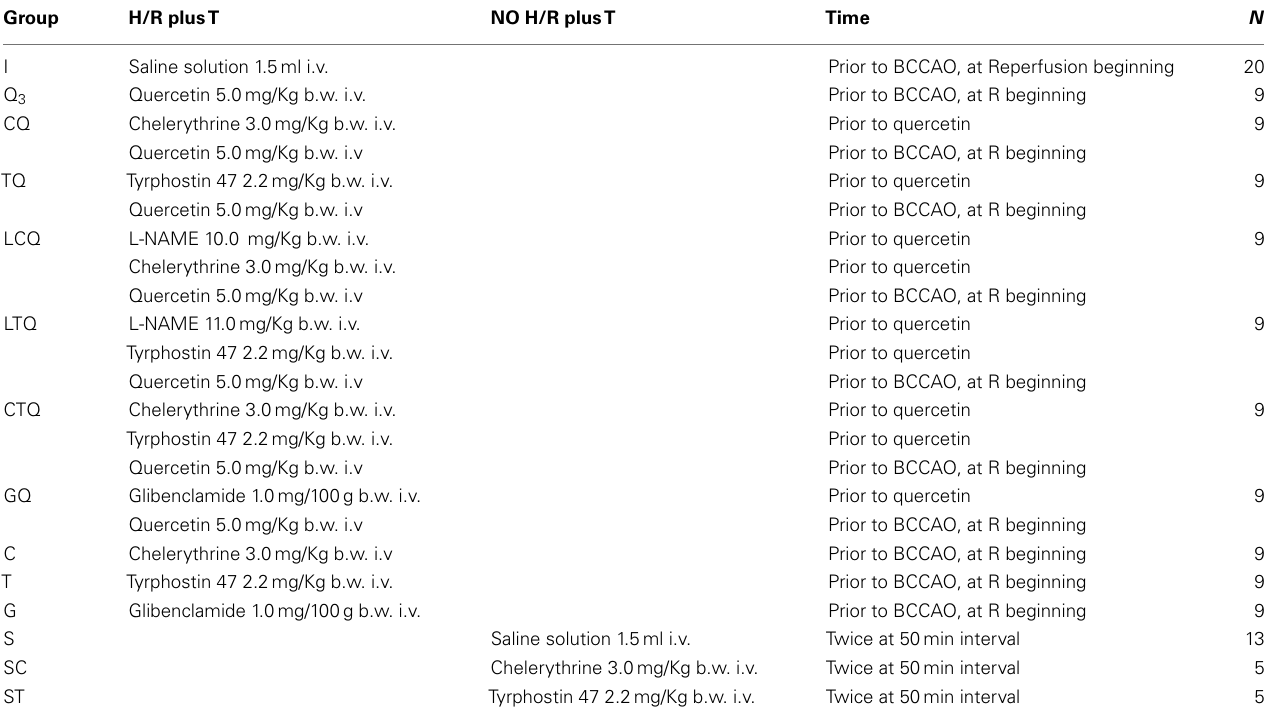
Table 1 | Drug treatment (T): doses, route, and time of administration in the different experimental groups. Group